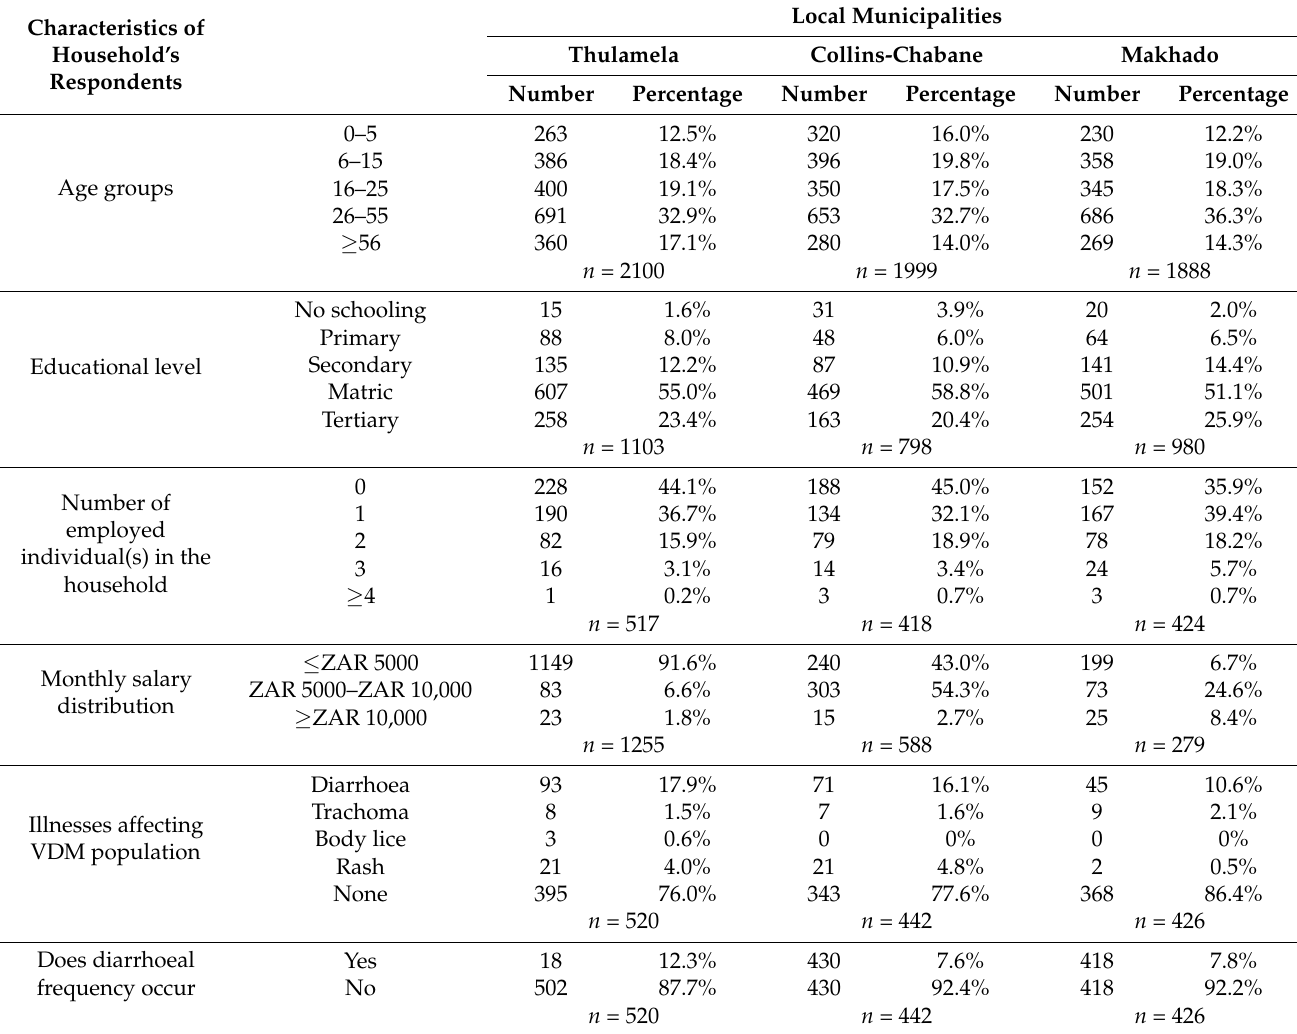
Table 1. Socio-demographic characteristics and history of water-related